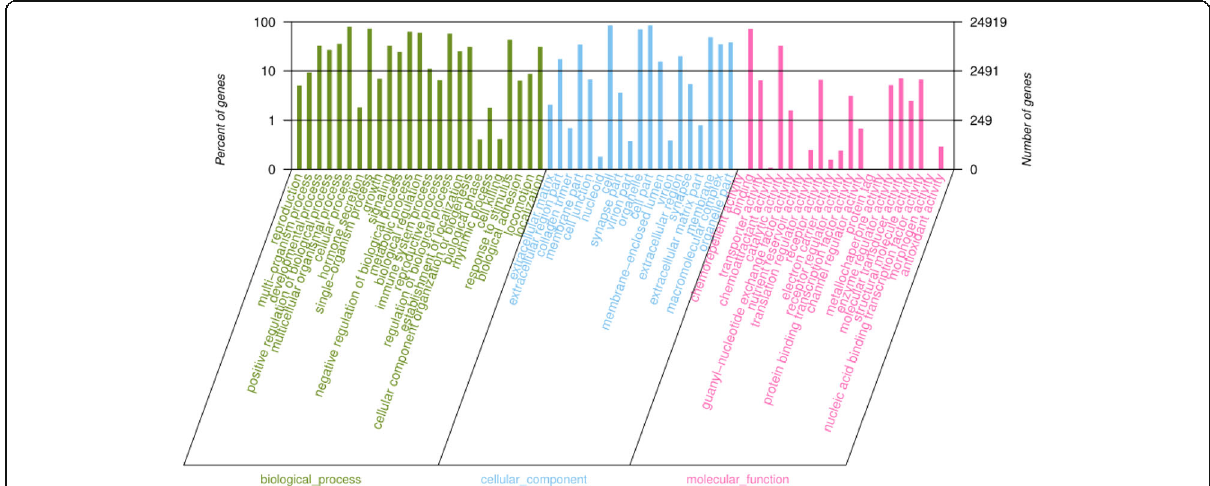
Fig. 5 The GO terms of target genes of 50 differentially expressed miRNAs. The χ -axis indicates the subcategories; the left and right y -axis indicates the percent and the number of differentially expressed genes, respectively